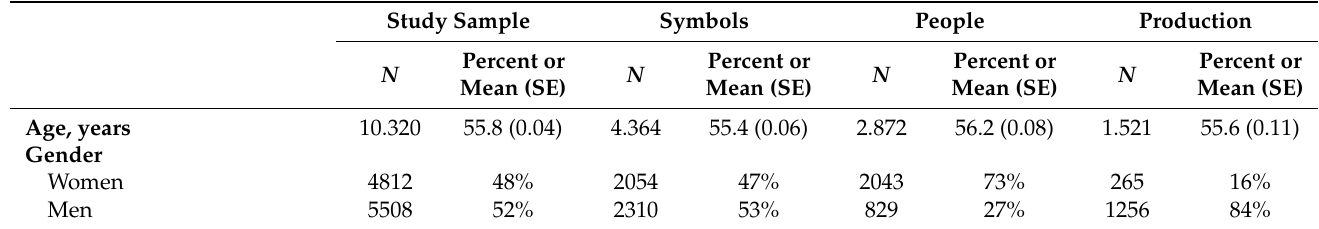
Table 1. Baseline characteristics of the entire study sample (N = 10,320) and stratified by job function category (work with symbols, work with people, work in the field of production). Study Sample Symbols People